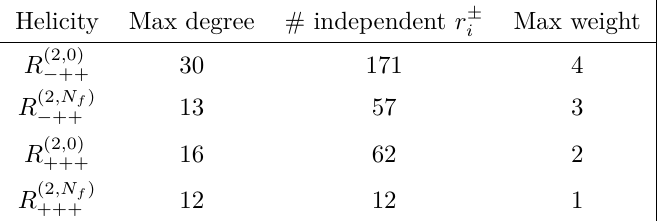
Table 3. Characterizing data for analytic expressions of two-loop remainders, see eq. (2.19) and the discussion below for the notation. We use the same labels as in table 2. ‘Max weight’ is the highest transcendental weight of the pentagon functions appearing in each